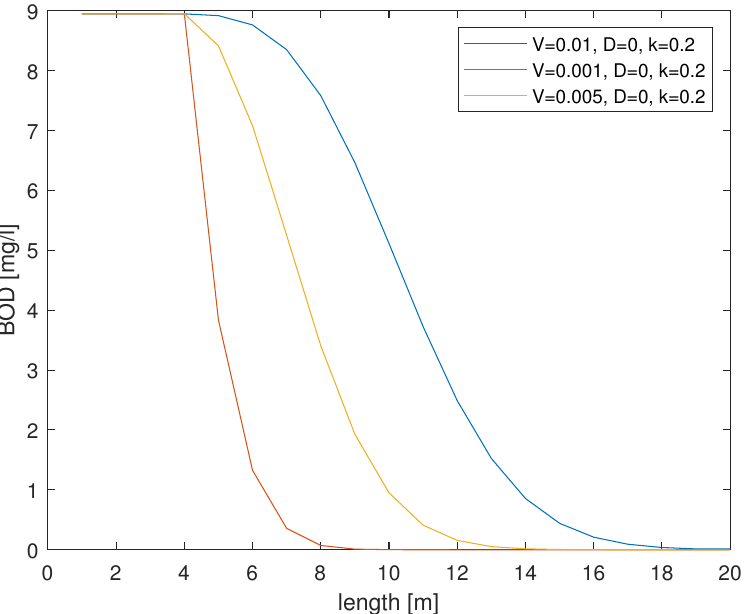
Figure 21. BOD distribution excluding diffusion, at different velocities in the same moments of time, considering the self-cleaning